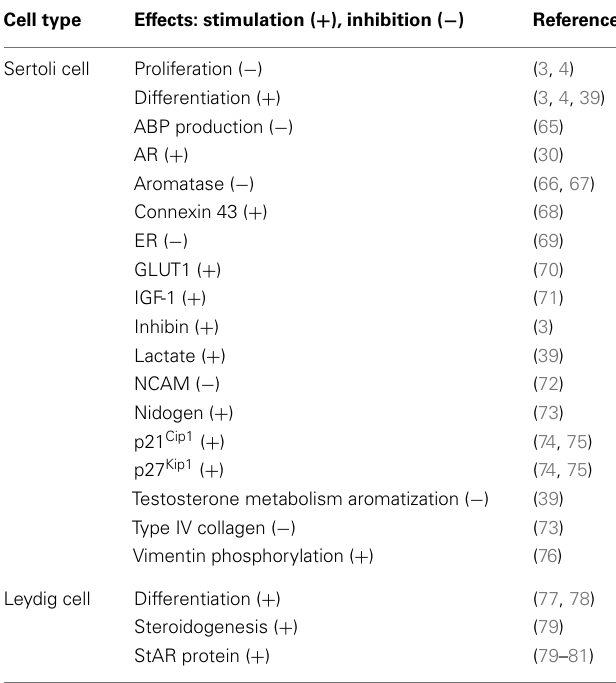
Table 1 | Effect of thyroid hormoneT3 on testes